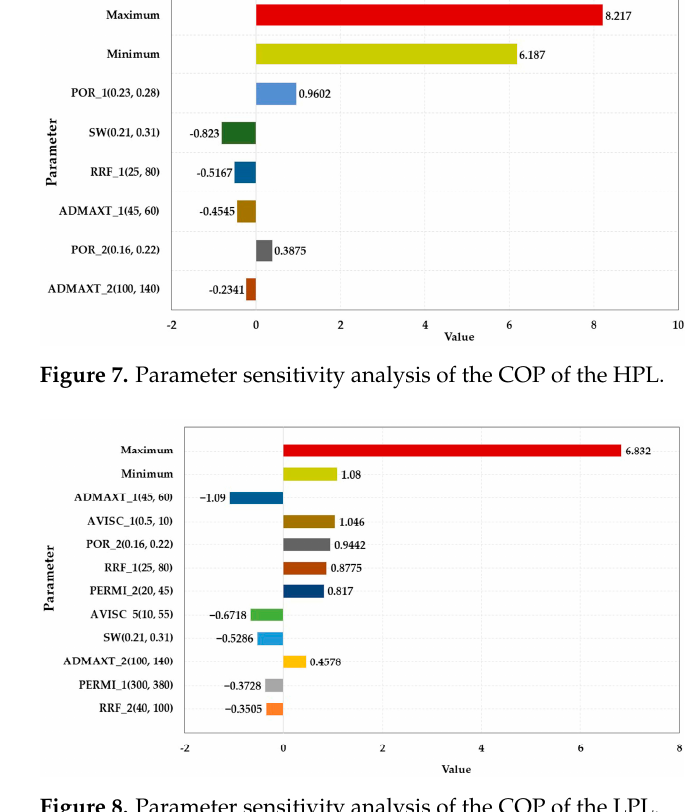
Figure 8. Parameter sensitivity analysis of the COP of the LPL.